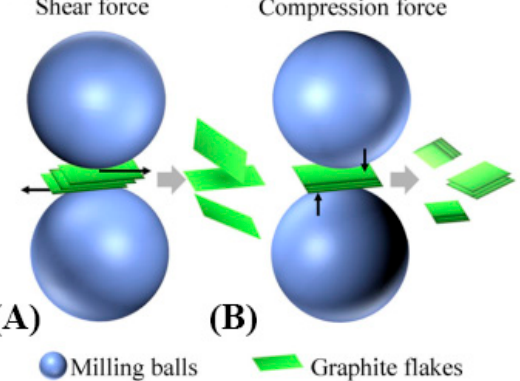
Figure 4. Schematic illustration for graphene exfoliation by ball milling. ( A ) Shear force–induced ex- foliation; ( B ) Compression force–induced fracture. Reprinted with permission from [50]. Copyright@ John & Wiley